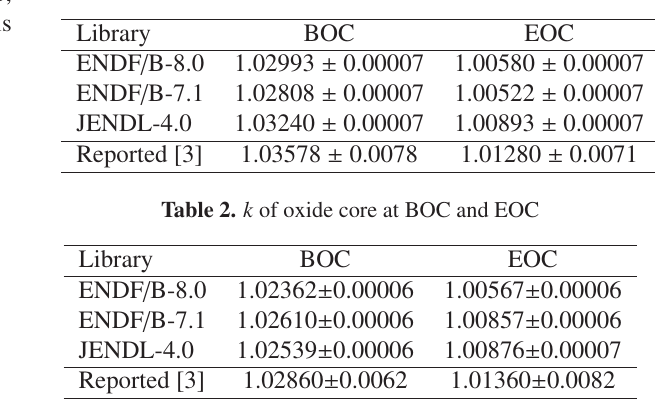
Table 1. k of metallic core at BOC and EOC